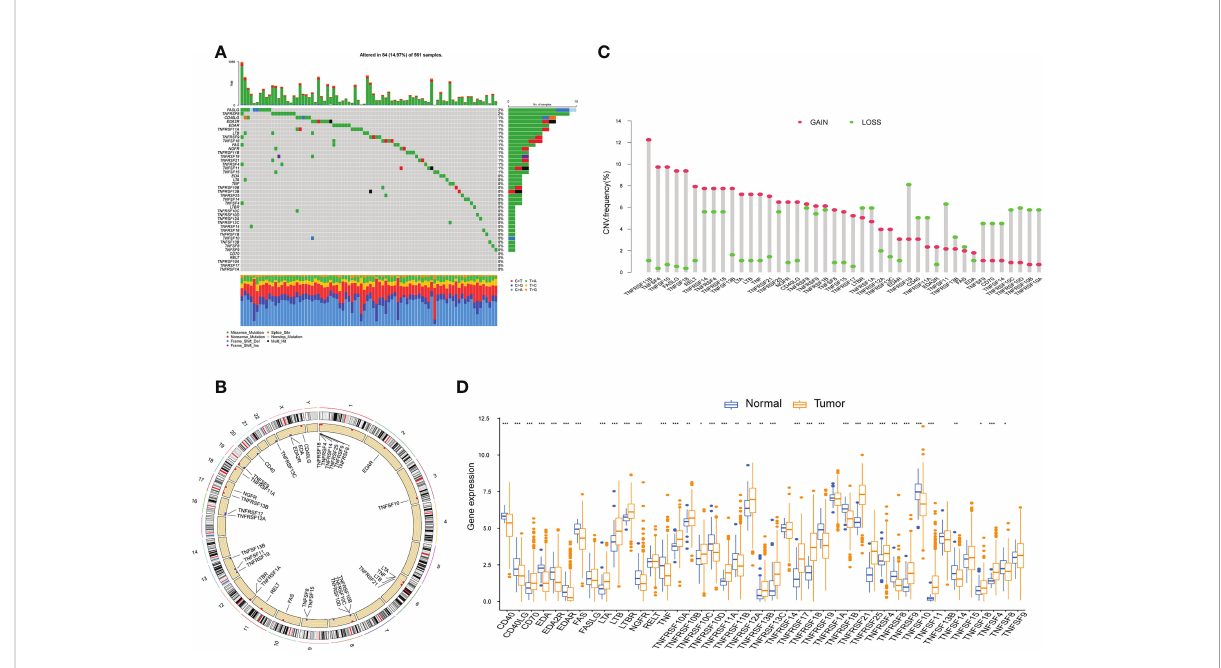
FIGURE 1 The multiomics landscape of the TNF family in LUAD. (A) Mutation frequency of 43 TNFRGs in patients with LUAD from the TCGA cohort. (B) Locations of CNV alterations of the TNFRGs on chromosomes. (C) Frequencies of CNV gain, loss, and nonCNV among the TNFRGs . (D) Boxplot shows the expression distributions of DEGs between LUAD and normal tissues; *p < 0.05, **p < 0.01, ***p <